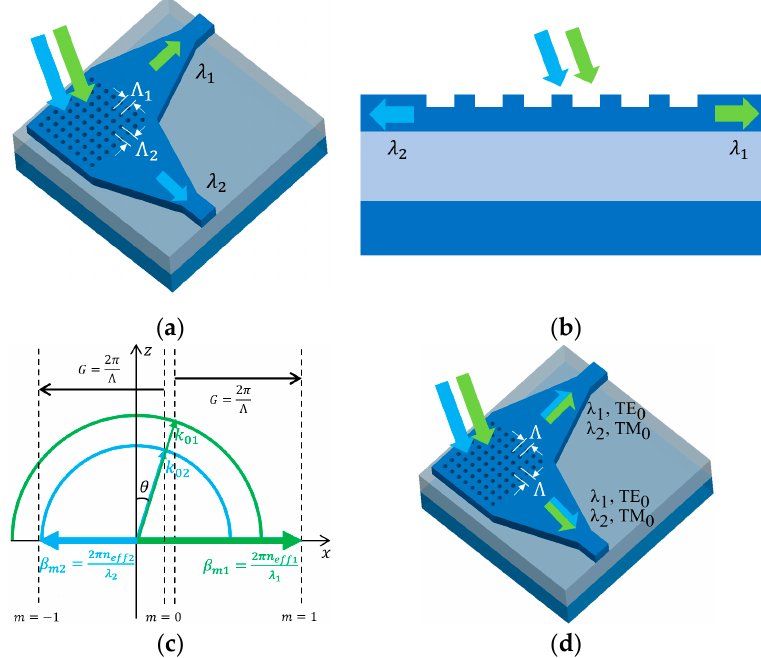
Figure 8. Dual ‐ wavelength ‐ band GCs: ( a ) two bands coupled to orthogonal waveguides; ( b ) two Figure 8. Dual-wavelength-band GCs: ( a ) two bands coupled to orthogonal waveguides; ( b ) two bands coupled to opposite waveguides; ( c ) wave ‐ vector diagram for 1D dual ‐ wavelength ‐ band GC; bands coupled to opposite waveguides; ( c ) wave-vector diagram for 1D dual-wavelength-band GC; and ( d ) 2D PSGC that supports dual wavelength bands. and ( d ) 2D PSGC that supports dual wavelength